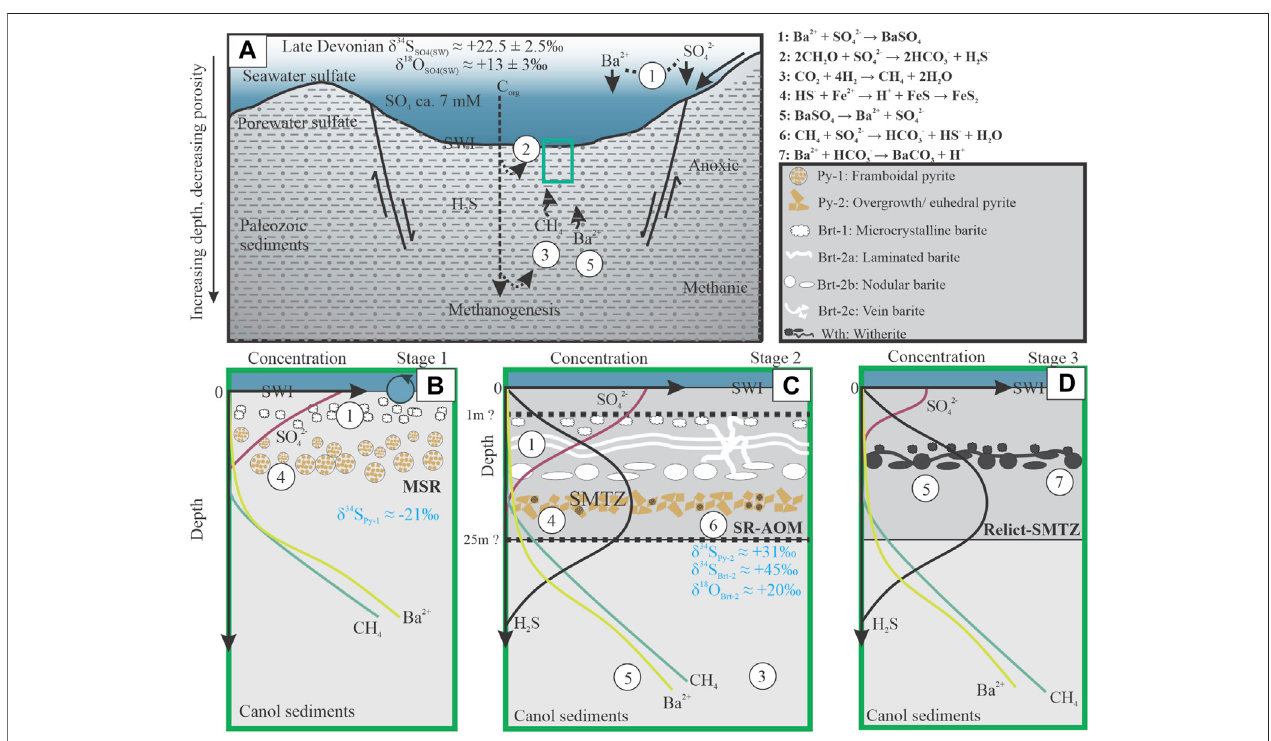
FIGURE 15 | (A) schematic illustration of temporal Late Devonian diagenetic processes in the Canol Formation of the Selwyn Basin, depicting sulfur cycle and stages of the formation of the two sulfur sinks (barite and pyrite) and witherite (no scale implied; modi fi ed from Hanor, 2000; Magnall et al., 2016; Zan et al., 2020). (A) Cross-section showing a portion of the Selwyn Basin on the western North American continental margin in the Late Devonian (modi fi ed from Hanor, 2000). Sulfate (SO 42- ) fromtheterrestrialenvironmentisdeliveredtothemarineenvironment.Biogenicbarite(1)formsandisdeliveredtothesea fl oorviafecalpelletsandmarineshowers, which get buried and inherit the Late Devonian seawater ( δ 34 S values (cid:1) 20 – 25 ‰ ). Organic matter (C org ) is deposited together with sediments where degradation is continuous through (2) below the sediment-water interface (SWI) with SO 42- as oxidant and continuous deep down the sediment column via methanogenesis (3). (B) Framboidal pyrite (Py-1) represents a sink for H 2 S with negative δ 34 S values produced during microbial sulfate reduction (MSR). Dissolution of the biogenic barite provides Ba to form authigenic (diagenetic) barite (Brt-1) under an apparent open system condition. (C) Development of diagenetic redox front, the sulfate-methane transition zone (SMTZ), resultingfrom diffusionofmethaneand Ba-rich fl uids from the depth and downward diffusing sulfate. Theinteractionallowed for theformationof 34 S-enriched laminated (Brt-2a), nodular (Brt-2b), and vein (Brt-2c) barite above the SMTZ and highly 34 S-enriched pyrite (Py-2) along this sulfate reduction coupled to anaerobic oxidation of methane (SR-AOM) zone under a restricted depositional setting. (D) severe sulfate undersaturation allowed for large-scale barite dissolution and formation of Ba-bearing phases, e.g., witherite at the relict SMTZ. See the text for a detailed explanation.